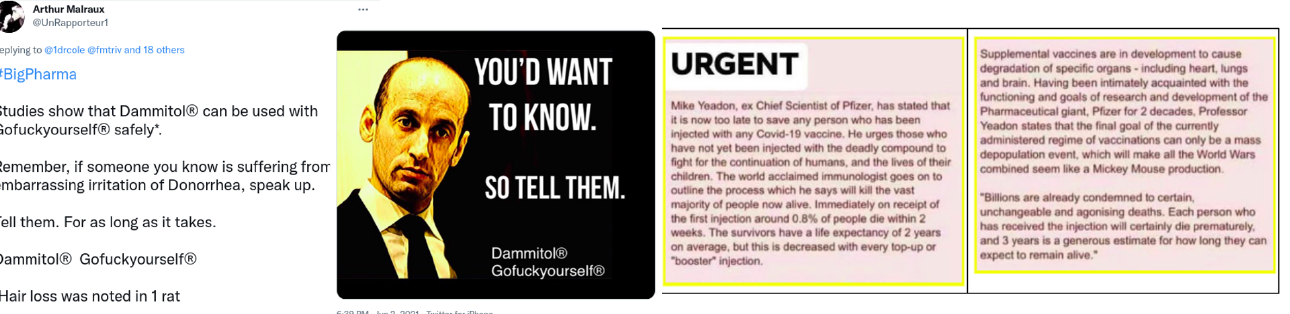
Figure 12. Example of a suspicious account in the Big Pharma analysis ( right ) and example of a suspicious account posting conspiracy tweets in the great reset analysis ( left ).